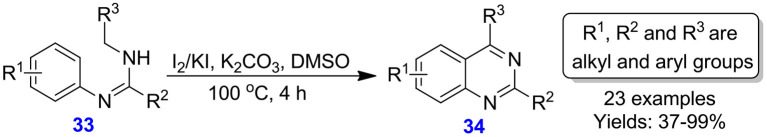
Cyclization of arylamidines catalyzed by I2/KI.